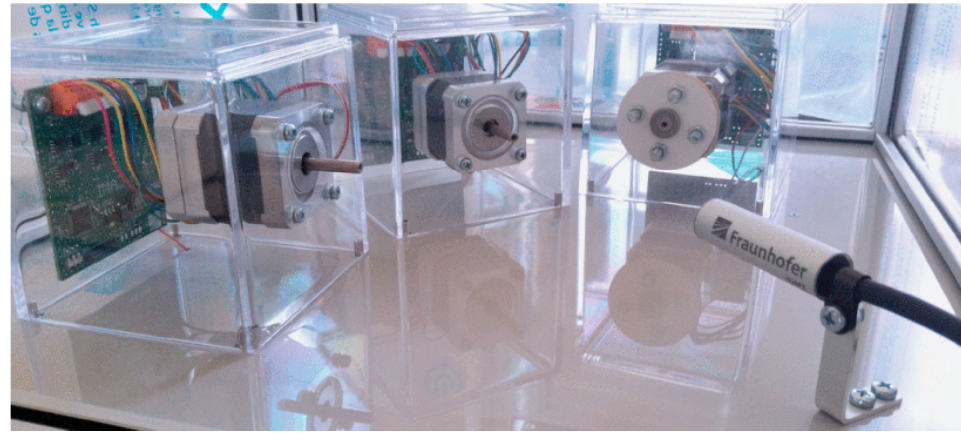
Figure 14. Three electric motor setups for IDMT-ISA-ELECTRIC-ENGINE dataset [14].